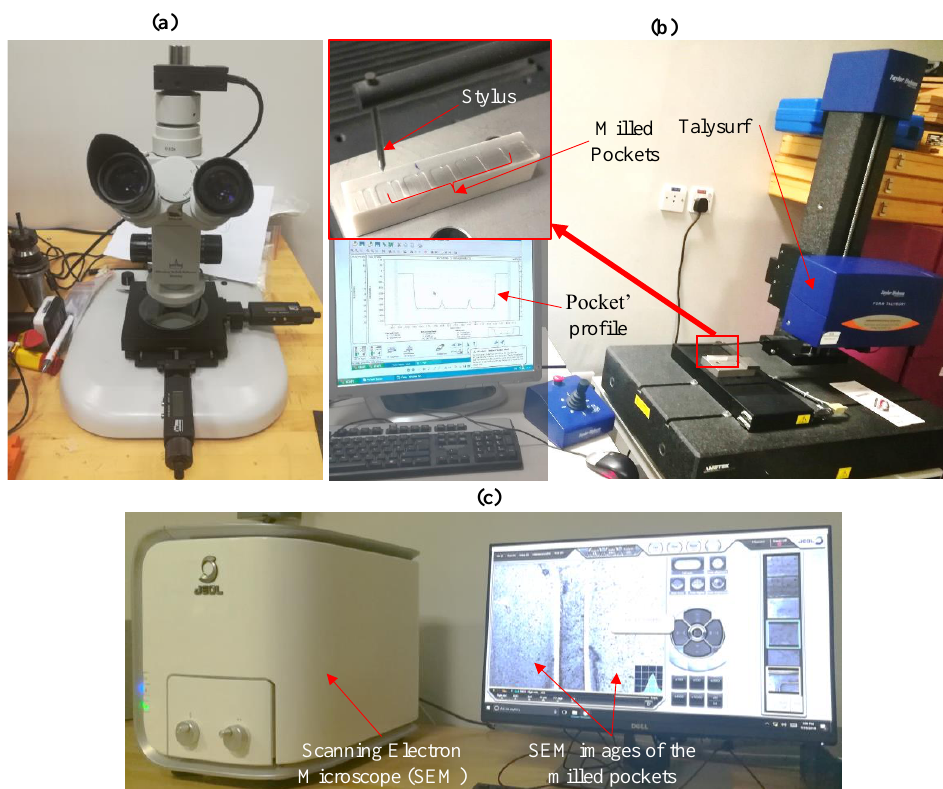
Figure 5. Outputs measurement procedure: ( a ) optical microscope, ( b ) pockets profiles and surface roughness measuring set up, and ( c ) surface morphology measuring set up. Appl. Sci. 2020 , 10 , x FOR PEER REVIEW